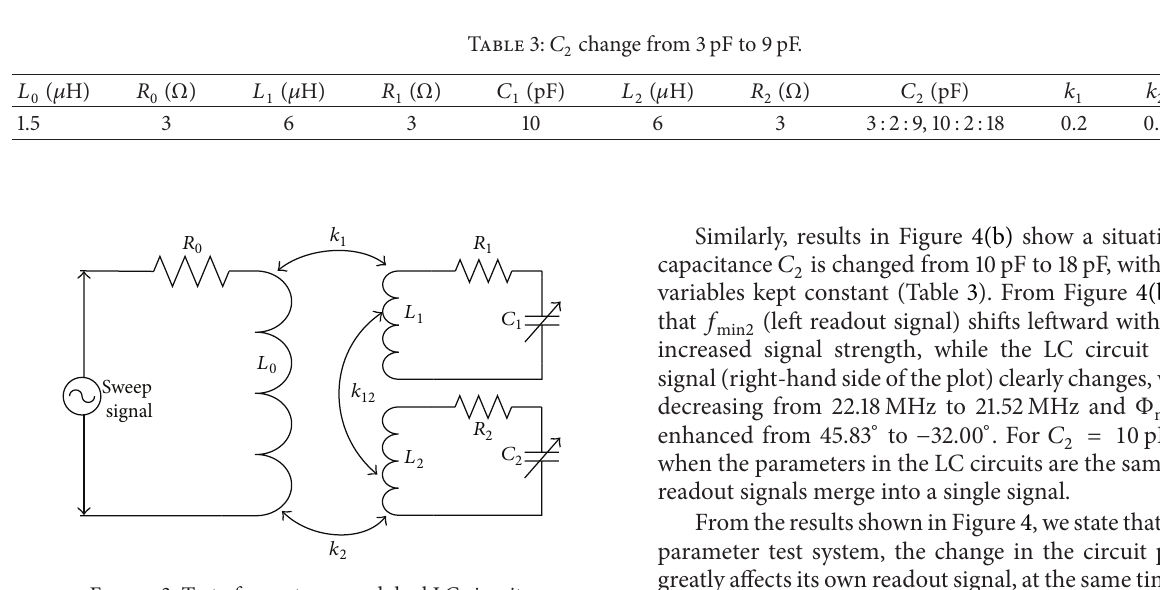
Figure 3: Test of an antenna and dual LC